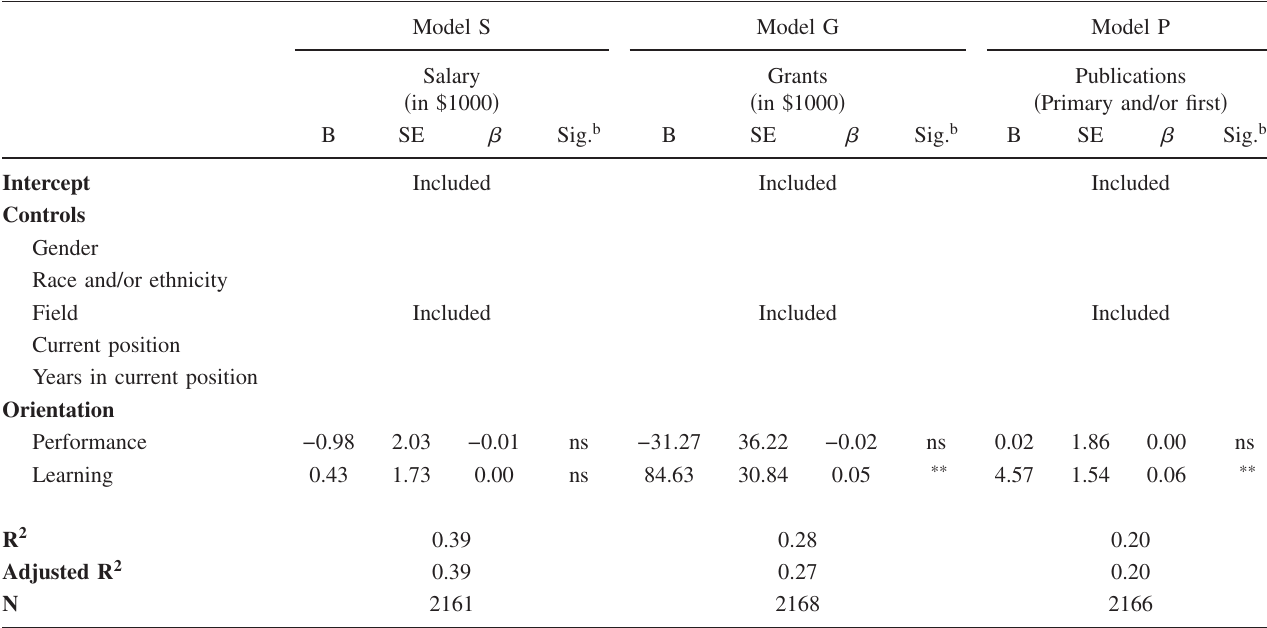
TABLE I. Multiple regression models a with outcomes of salary, grant funding, and primary and/or first-author publications.